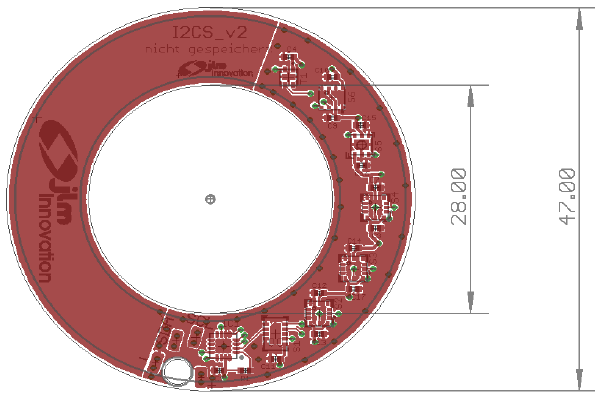
Figure 2. Technical design of the sensor device (all dimensions are in mm). The sensors are on the right side.